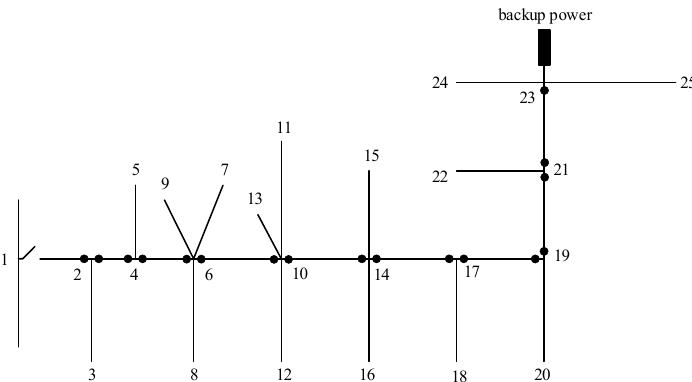
Figure 7. Example 1: alternative switch-position map (with contact).